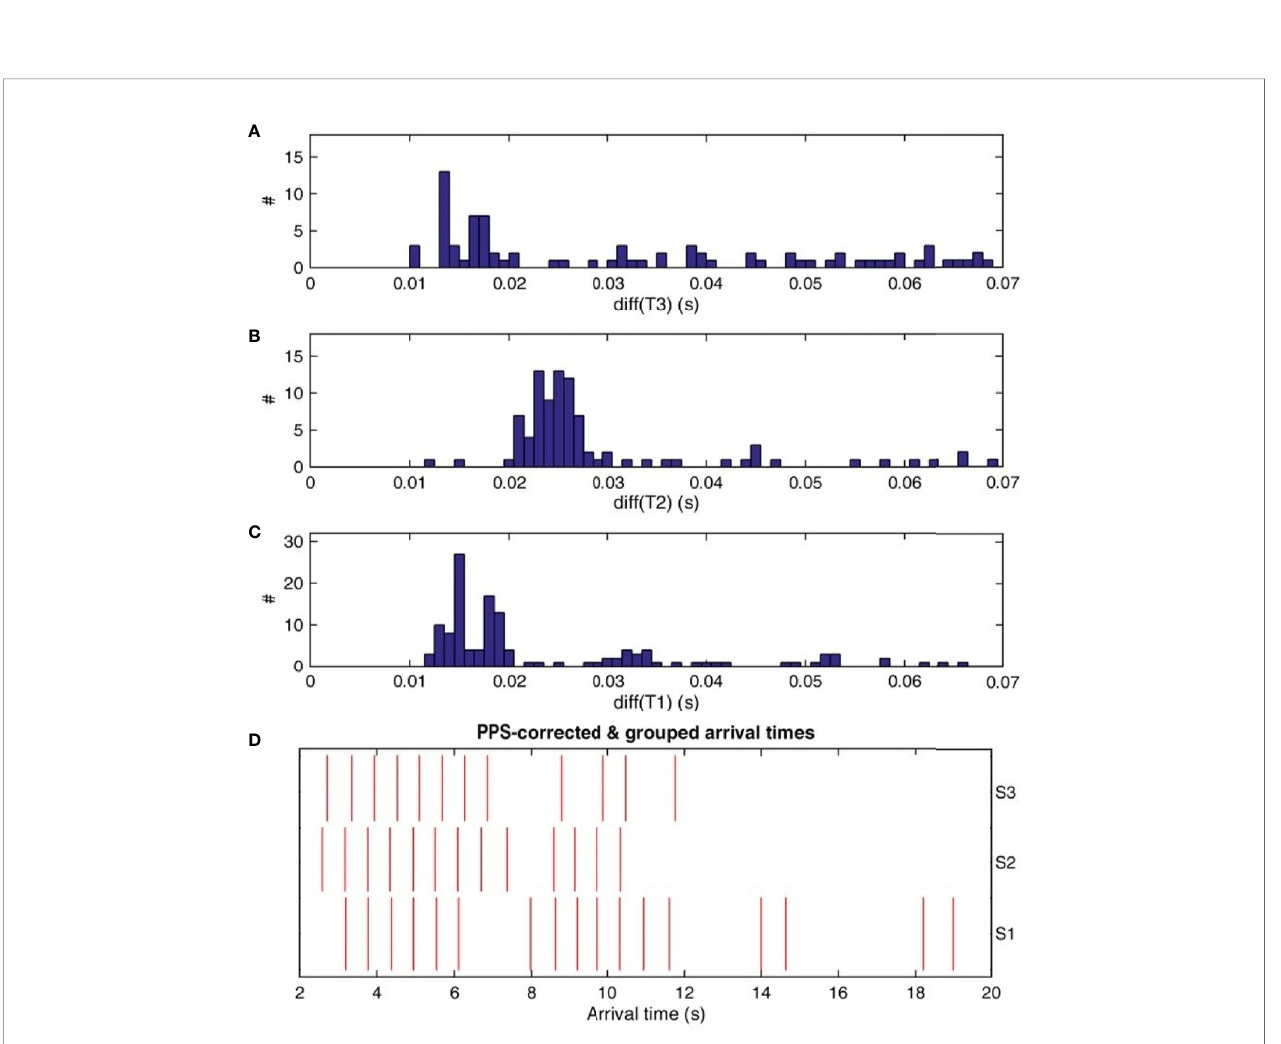
FIGURE 7 | Histograms of time differences (up to 70 ms) of arrivals recorded at (A) SWAN3, (B) SWAN2 and (C) SWAN1 and shown in Figure 6 ; the vertical axes (#) in panels (A – C) measure histogram counts. (D) Pairs of direct and surface-re fl ected arrivals corresponding to the histogram peaks in (A – C) – a subset of those shown in Figure 6 .